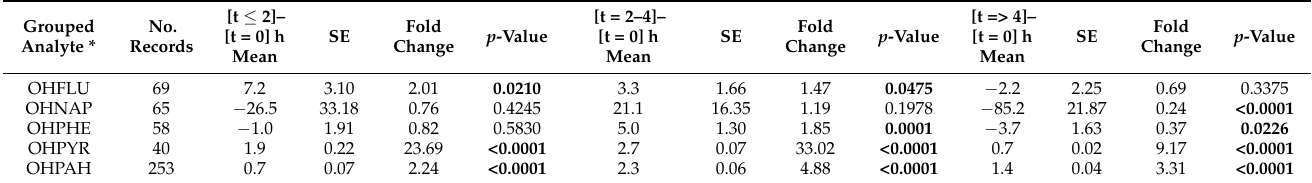
Table 4. Three sampling time windows (t < 2, t = 2–4, t > 4) and one baseline (t = 0) of OHPAH were collected from urine samples (unit: ng/g—creatinine) by grouped analytes. Bold p -value indicates statistically significant difference in urinary OHPAH levels at a sampling time point after and before fire